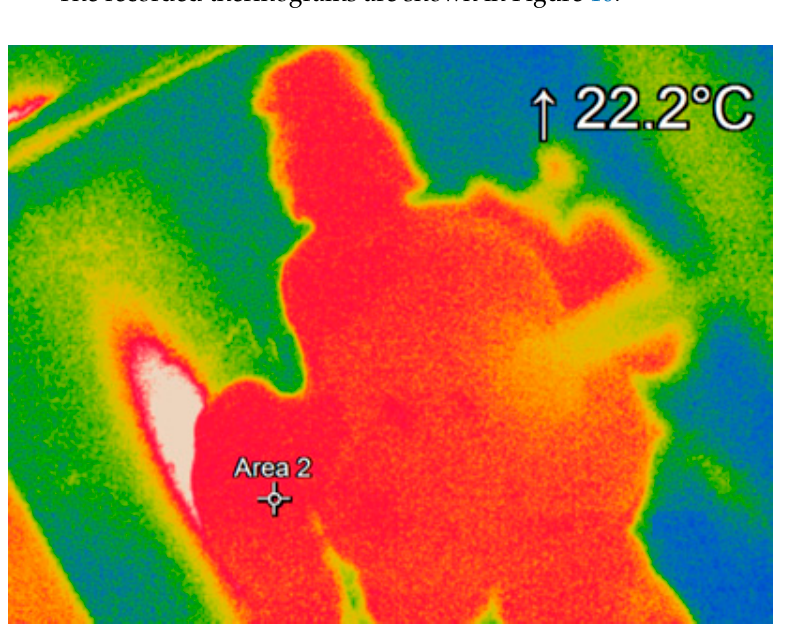
Figure 10. Thermograms recorded during measurements.